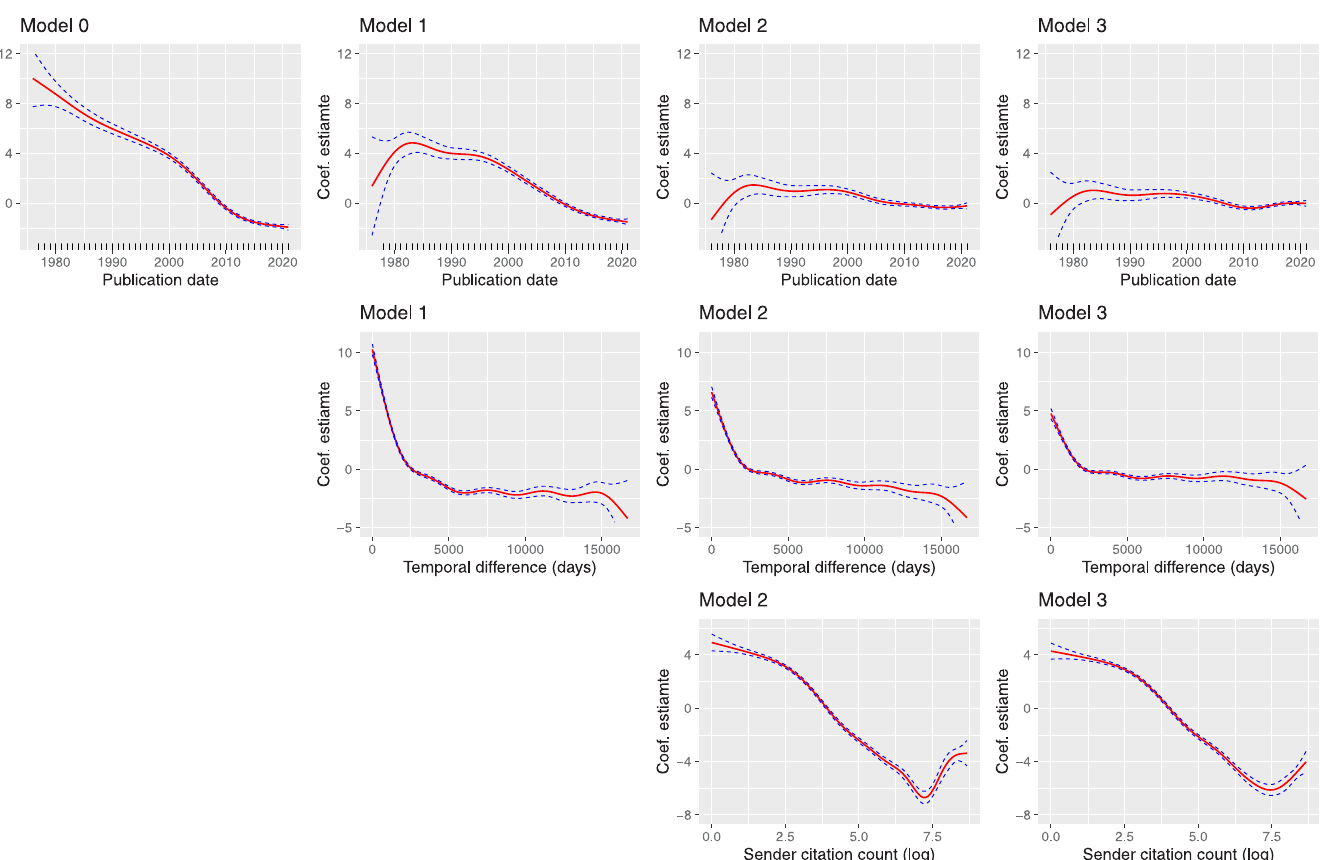
Fig 4. Model splines. Smoothing splines estimates for the three fitted GAMs. Columns : Effects fitted per model. Rows : Comparison of the same effects for the distinct models. Assessment criteria can be found at the bottom of Table 2.